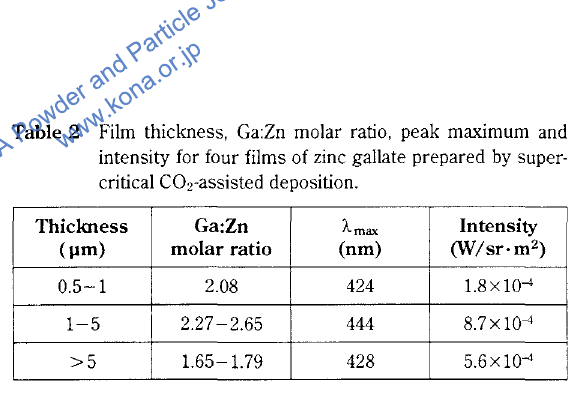
Fig. 11 Manganese-doped zinc gallate deposited onto textured sil icon, lighter portion of image indicates the film coating.